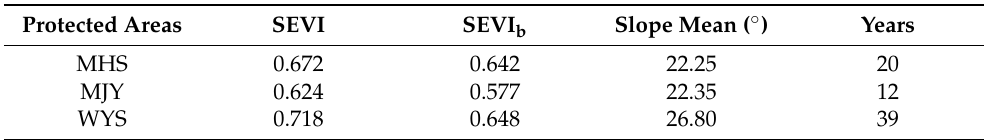
Table 2. SEVI mean of protected area and buffer zone (SEVI b ), slope mean, and years of establishment of protected